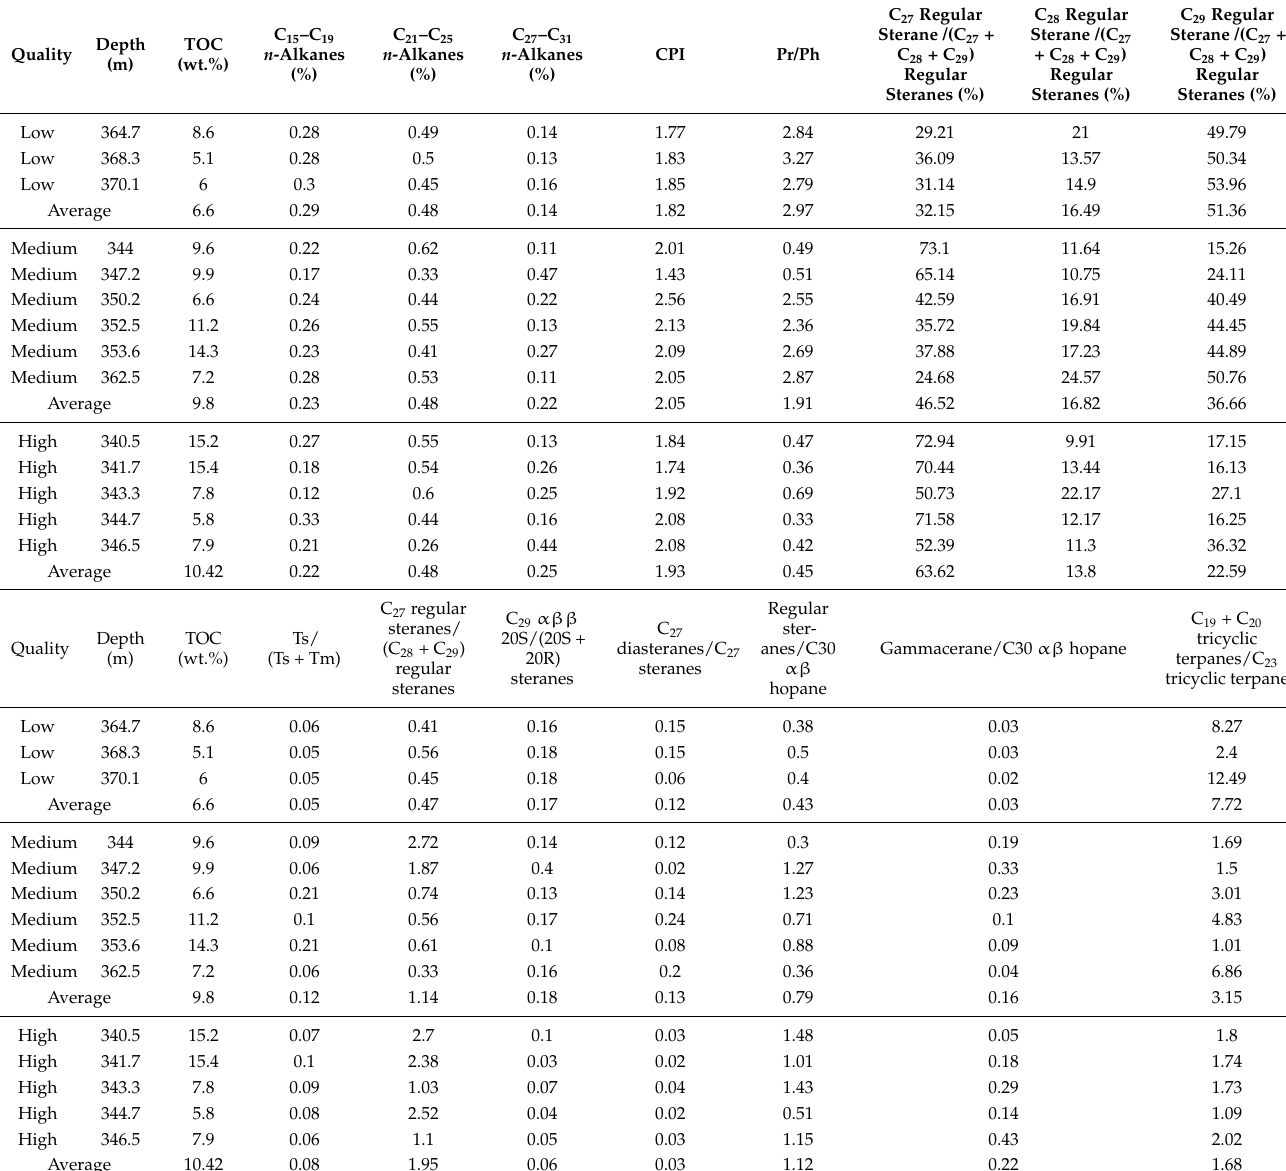
Table 4. Hydrocarbon and biomarker parameters for different-quality oil shales in the Shale Member of the Middle Jurassic Shimengou Formation, Yuqia area, Qaidam